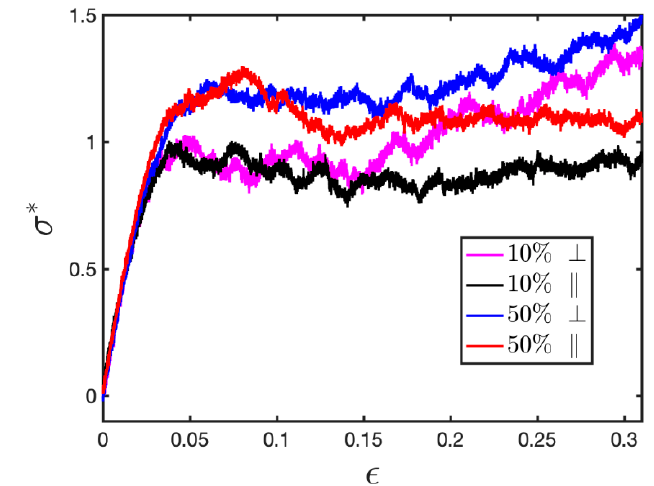
Figure 7. Stress-strain relation of lamellar ionic di-BCPs stretched perpendicular and parallel to the interface.